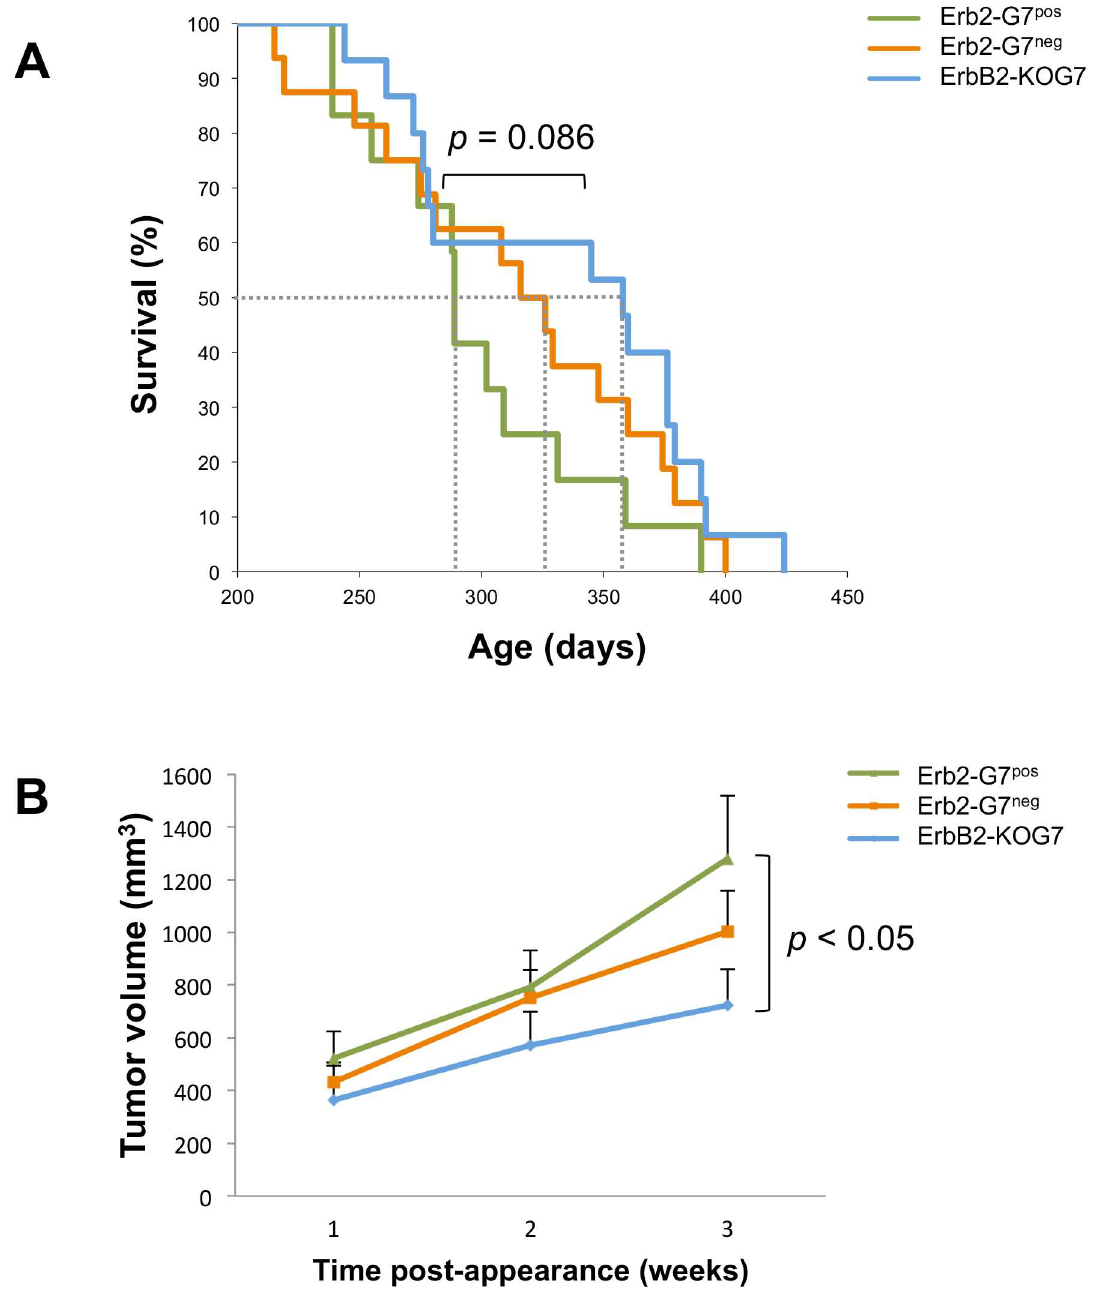
Fig 4. Decreased survival and higher tumor volume in presenceof gal-7 in MMTV-ErbB2 mammary tumorigenesis. A) Kaplan-Meier survival curves for each group: G7+ (presence of gal-7 in mammary carcinoma;n = 12), G7- (absenceof gal-7 in mammary carcinoma;n = 16) and KOG7 (lack of gal-7 throughoutthe body; n = 15). The mediansurvival of each group is: 289 days (G7+), 316 days (G7-) and 358 days (KOG7). The p value 0.086 was calculatedbetweenG7+ and KOG7 groups. Comparisonof G7- group to G7+ group ( p = 0.231) or KOG7 group ( p = 0.405). B) Average tumor volume of all mice from the specifiedgroup. The onset of the tumor was measuredand identifiedas the first week post-appearance. The p value < 0.05 was calculatedbetweenG7+ (n = 11) and KOG7 (n = 13) groups, three weeks after tumor appearance. Comparison of G7- (n = 14) group to G7+ group ( p = 0.33) or KOG7 group ( p =